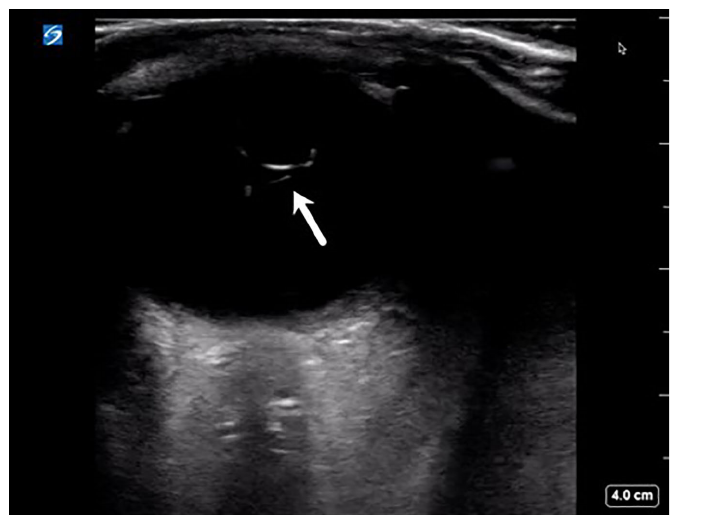
Image. Ultrasound image showing intraocular lens dislocation (arrow) into the posterior